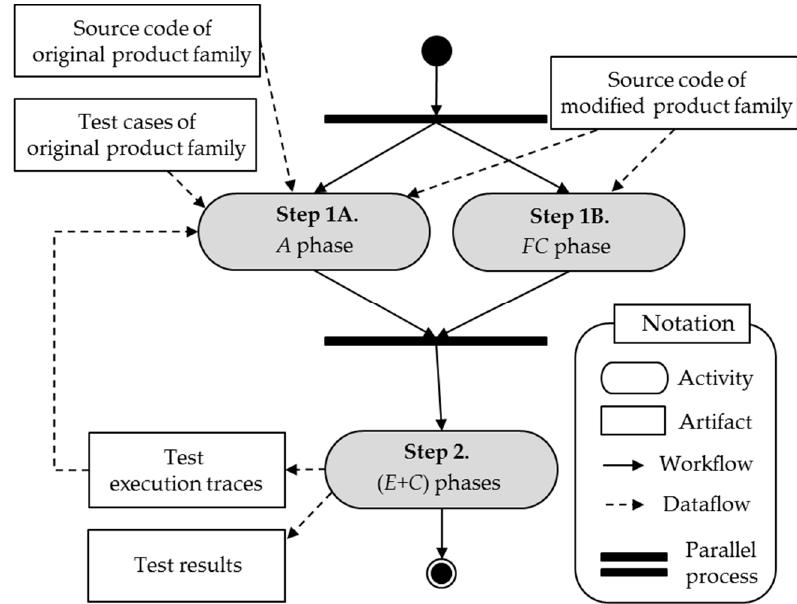
Figure 2. Overview of our method.